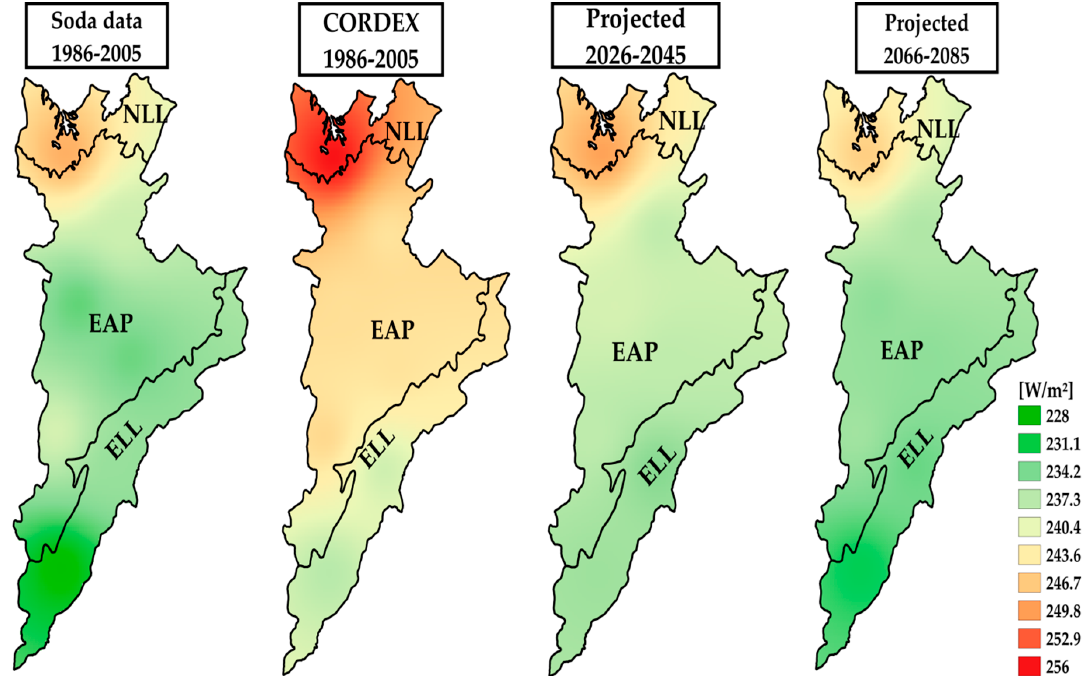
Figure 8. Historical and projected annual solar irradiance over the period 2026–2045 and 2066–2085 at